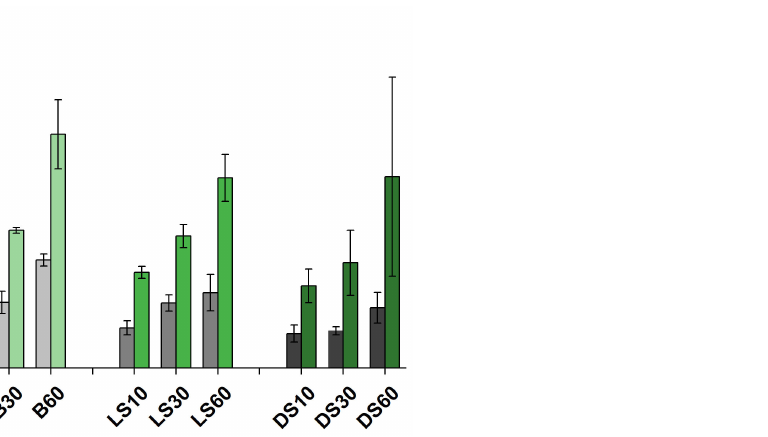
Figure 11. Char layer (in grey) and char and transition layer (in green) thicknesses (mm) in different modifications by species/wood